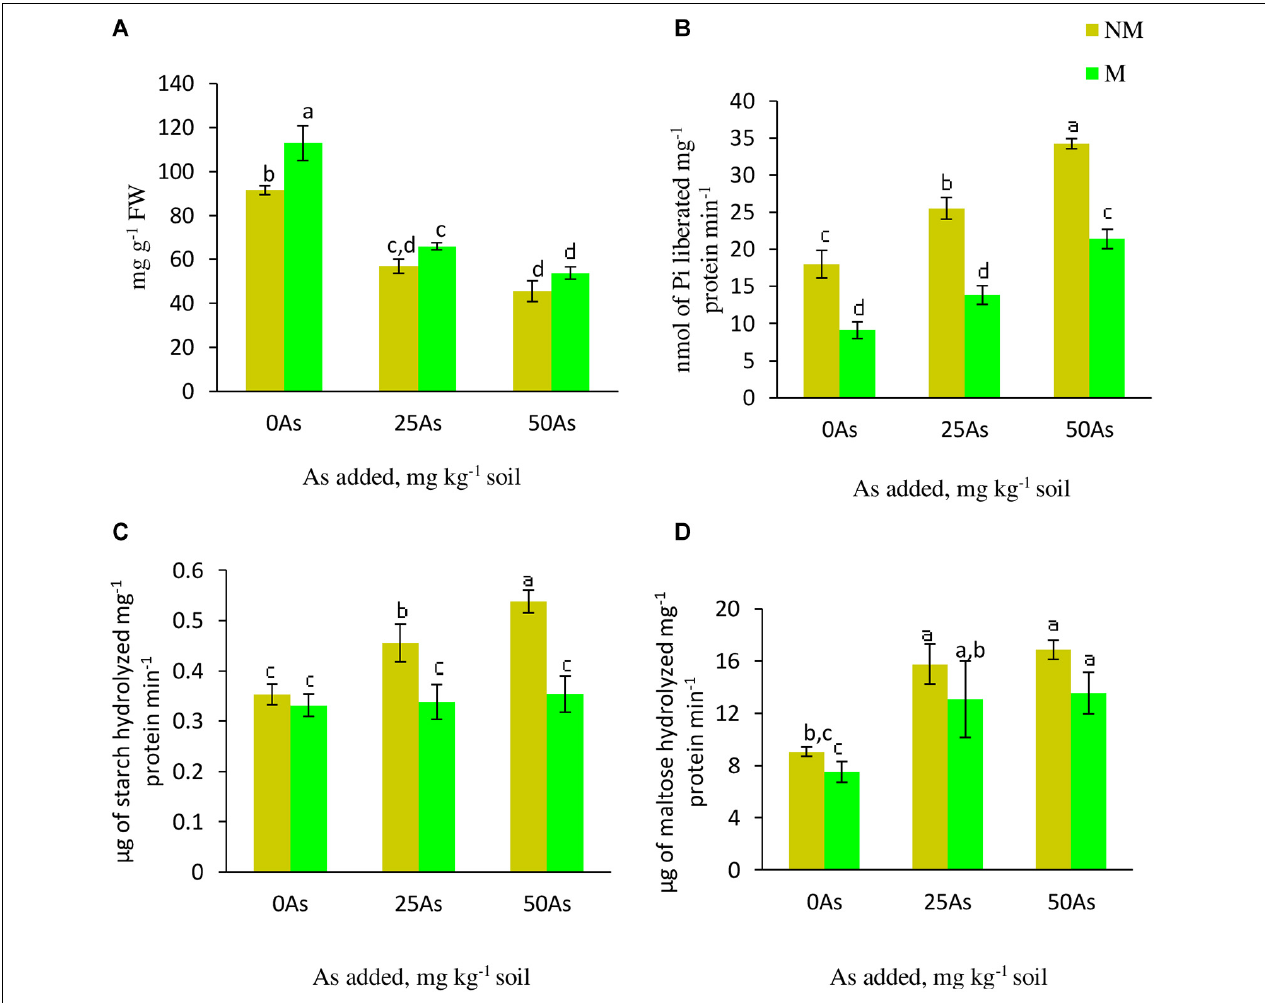
FIGURE 5 | Concentration of (A) starch and activities of starch metabolizing enzymes; (B) starch phosphorylase, SP; (C) α -amylase, and (D) β -amylase in leaves of Triticum aestivum in response to Rhizophagus intraradices inoculation (M, mycorrhizal; NM, non-mycorrhizal) and As addition to the soil. Values represent means of three biological replicates ± SD. Different letters represent significant difference at p ≤ 0.05 , derived from Tukey’s honestly significant difference (HSD). 0As, 0 mg As kg − 1 soil treatment; 25As, 25 mg As kg − 1 soil treatment; 50As, 50 mg As kg − 1 soil